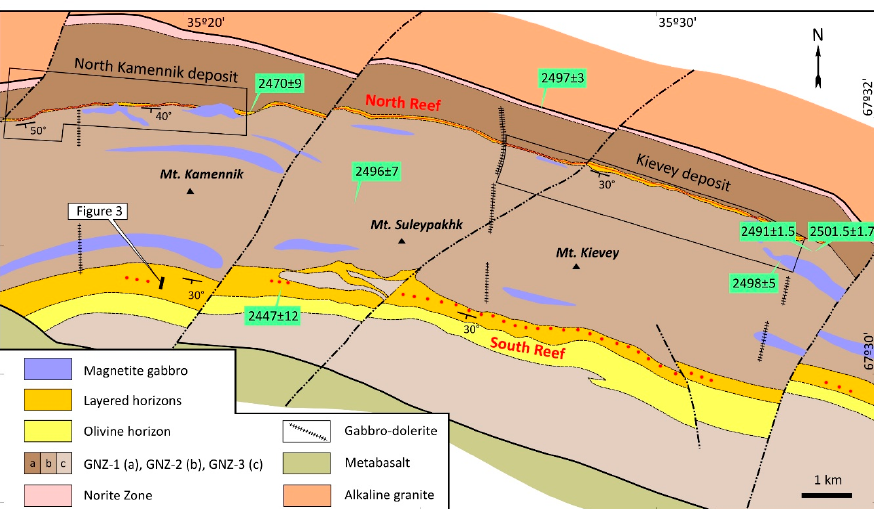
Figure 2. Simplified geological map of the West-Pana intrusion. Published U-Pb ages are shown in green rectangles. Note that the intrusion was explored for PGE mainly along strike of the North and South Reefs, but sub-economic to economic deposits were only discovered in the former. Abbreviations: GNZ, Gabbronorite Zone. Modified after [3].